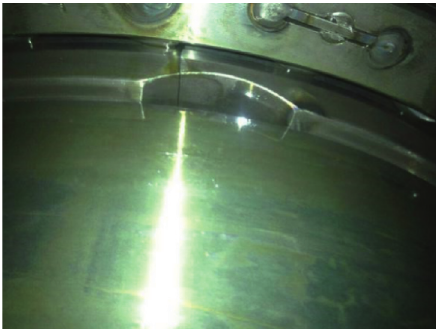
Figure 11: Gearbox bearing 1 with crack